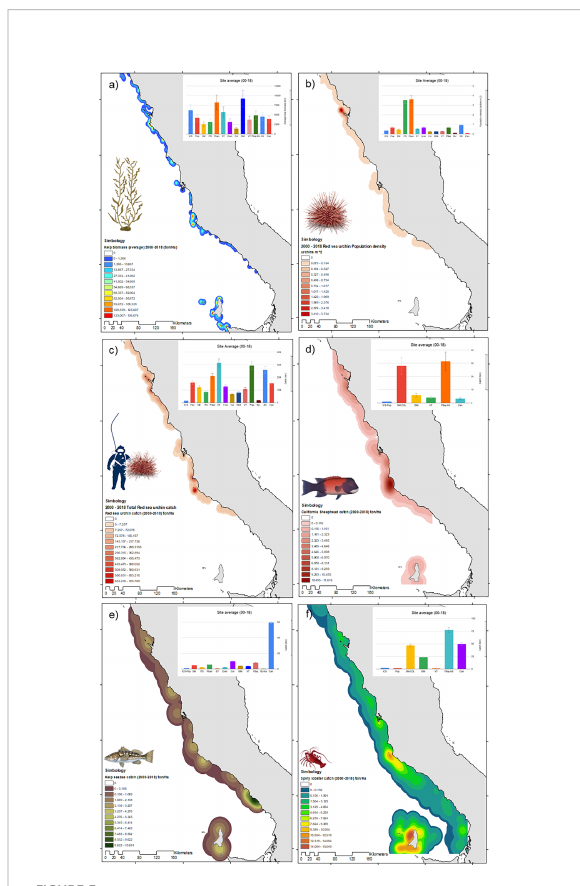
FIGURE 3 Distribution and density of (A) Kelp biomass, (B) population density of red sea urchin, (C) red urchin catch, (D) California sheephead, (E) kelp bass, and (F) spiny lobster catch, along the Paci fi c coast of Baja California. Data for